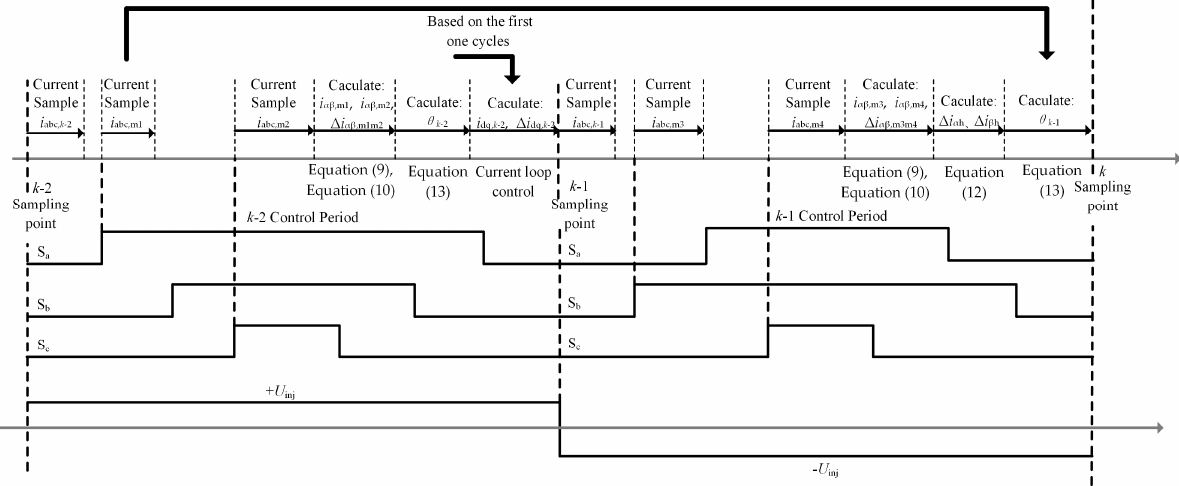
Figure 8. Program execution sequence diagram of the proposed method.